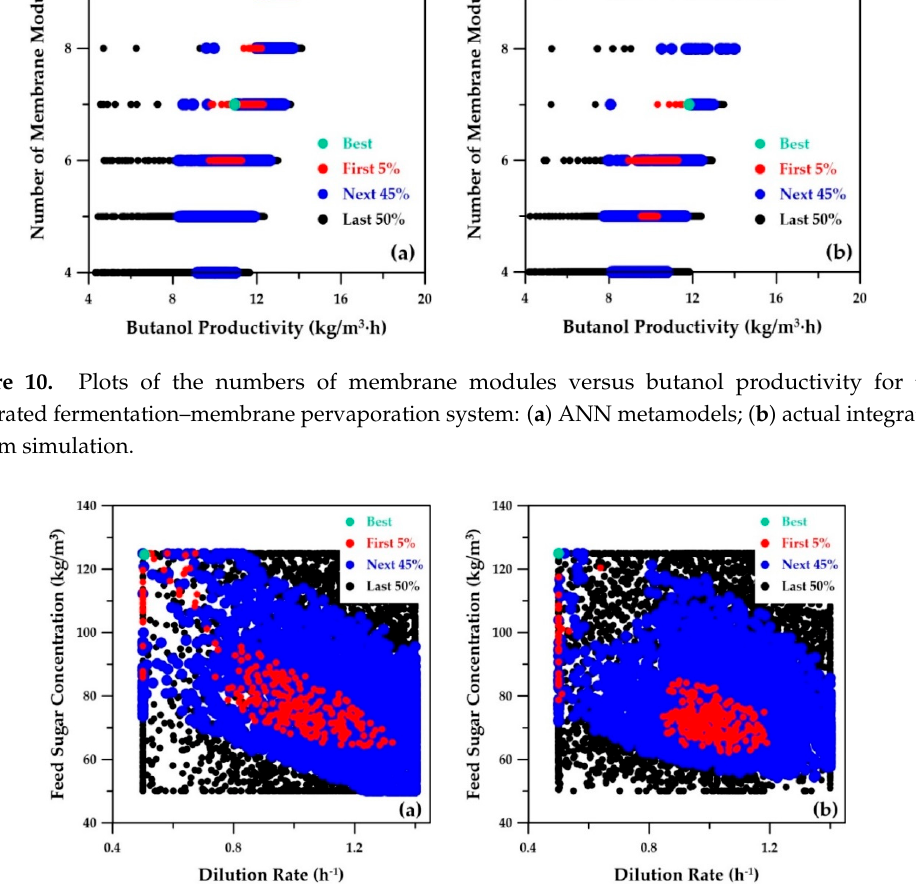
Figure 11. Plots of feed sugar concentration versus dilution rate for the integrated fermentation– membrane pervaporation system: ( a ) ANN metamodels; ( b ) actual integrated system simulation.